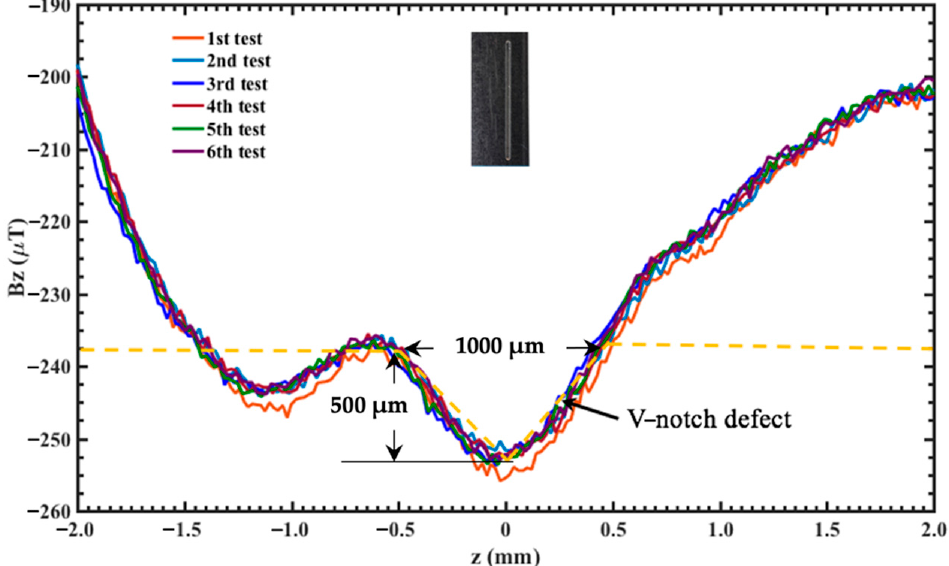
Figure 3. Variation of tangential MMM signals around the first V-shaped notch (1000 µ m width and 500 µ m depth) of the ASTM-A36 steel pipe, which were measured using six experimental tests. Figure 5 shows six measurements of tangential MMM signals around the second V-shaped notch (S2), which registered a minimum peak (–224.38 µ T ± 1.31 µ T) close to the defect center (z = 0 mm). Before this defect, the value of the tangential MMM signal decreased achieving its minimum magnitude near the notch center. After the defect center, the tangential MMM response increased. The magnetic field shift was caused by the defect depth (1000 µ m) along the outer surface of the pipe, registering a maximum variation (16.08 µ T ± 1.86 µ T) at the notch center. Six measurements of normal MMM signals around the second notch (S2) are shown in Figure 6. Before the first edge of the second